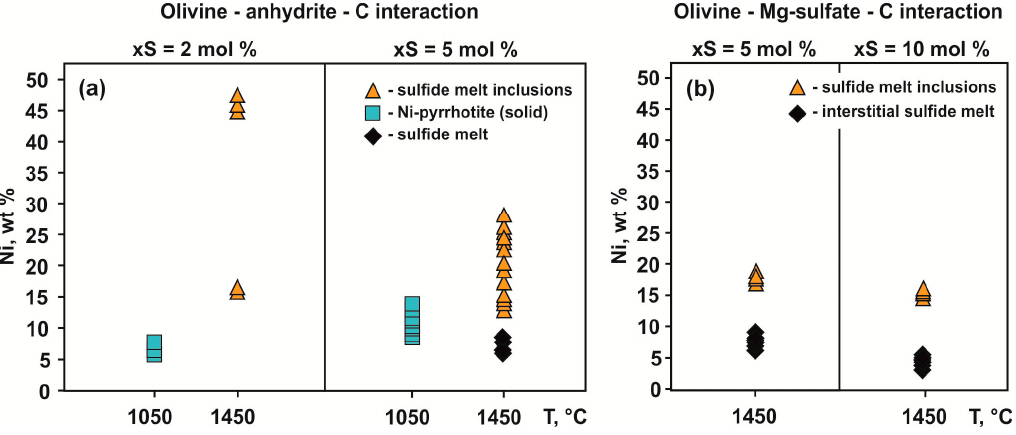
Ol—olivine, Cpx—clinopyroxene, Opx q —quenched orthopyroxene, Fms q —quenched ferromagnesite, Liq1—silicate-oxide melt, Liq2—carbonate-silicate melt, N A —number of analyses, n(O)—number of oxygen atoms; The values in parentheses are one sigma errors of the means based on replicate electron microprobe analyses reported as least units cited.